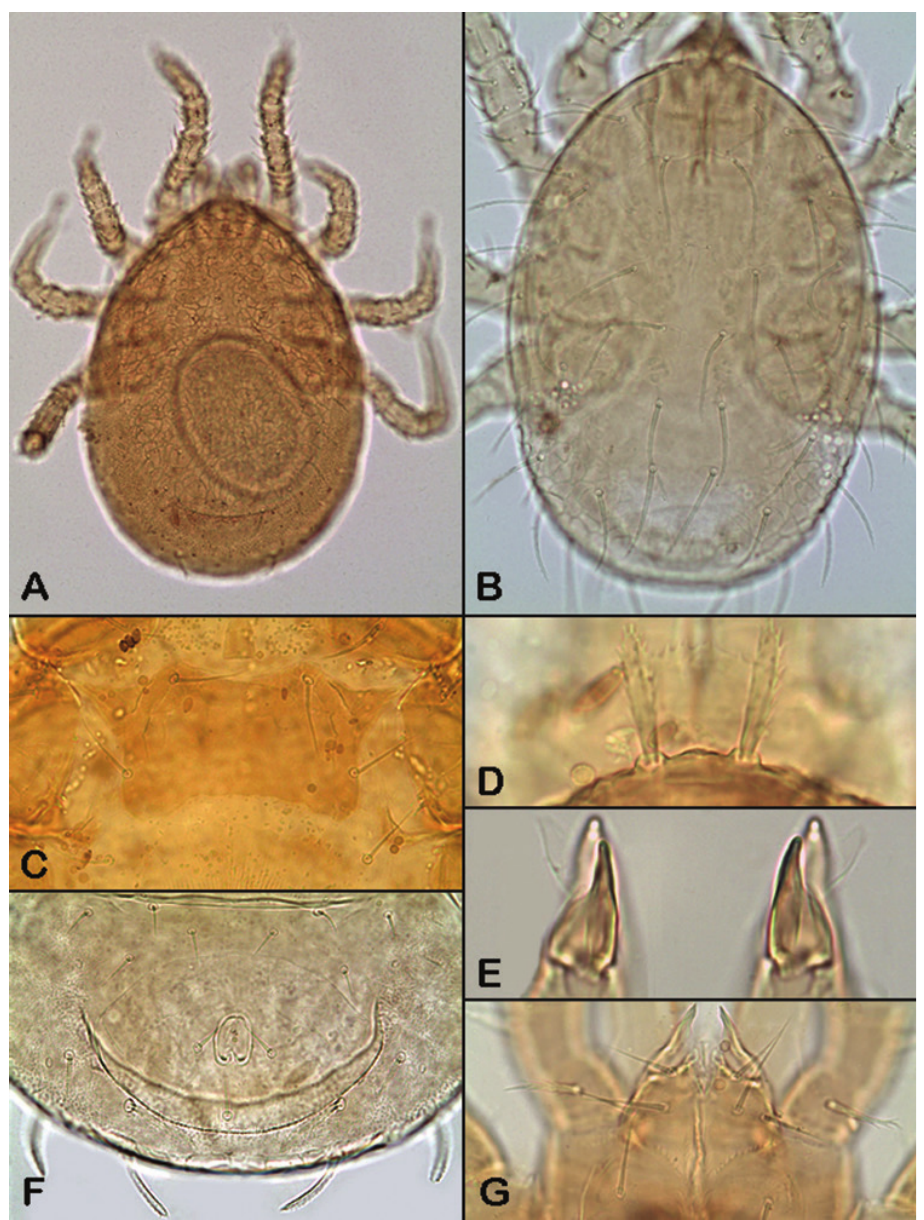
Plate 65. Neocypholaelaps favus . A Dorsal idiosoma with legs, female B Dorsal idiosoma, male C Sternal shield, female D Setae j1 and epistome, female E Cheliceral digits, female F Anal shield G Hypostome, ventral